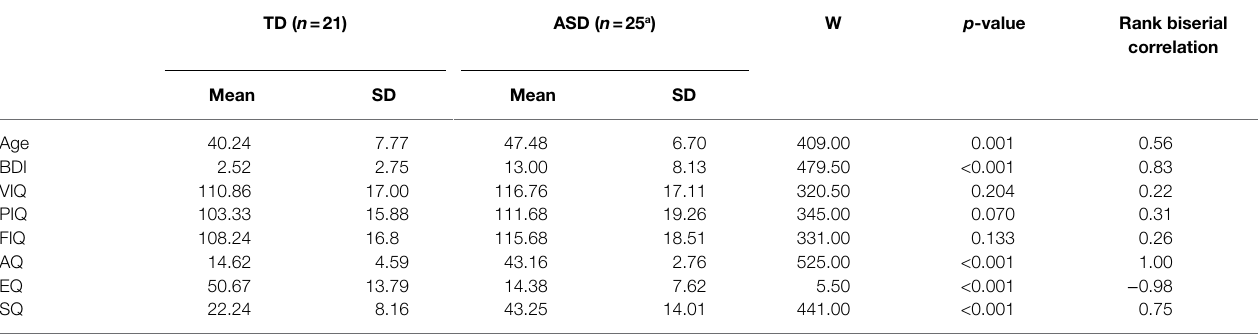
data sets (16 males, 9 females) and 21 TD data sets (8 males, 13 females). All participants were between 24 and 56 years old. The autistic individuals were older (M = 47.48, SD = 6.56) than TD individuals (M = 40.24, SD = 7.58). However, the groups were matched by verbal IQ, performance IQ, and full IQ (see Table 1 for descriptive statistics and